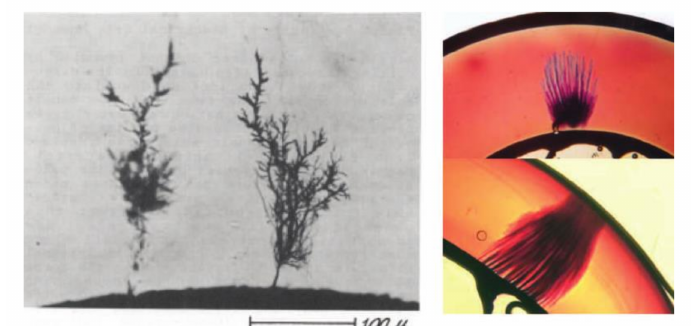
Figure 2. Magnified image of a water tree in cross-linked polyethylene (XLPE) with voids and channels connecting the voids.